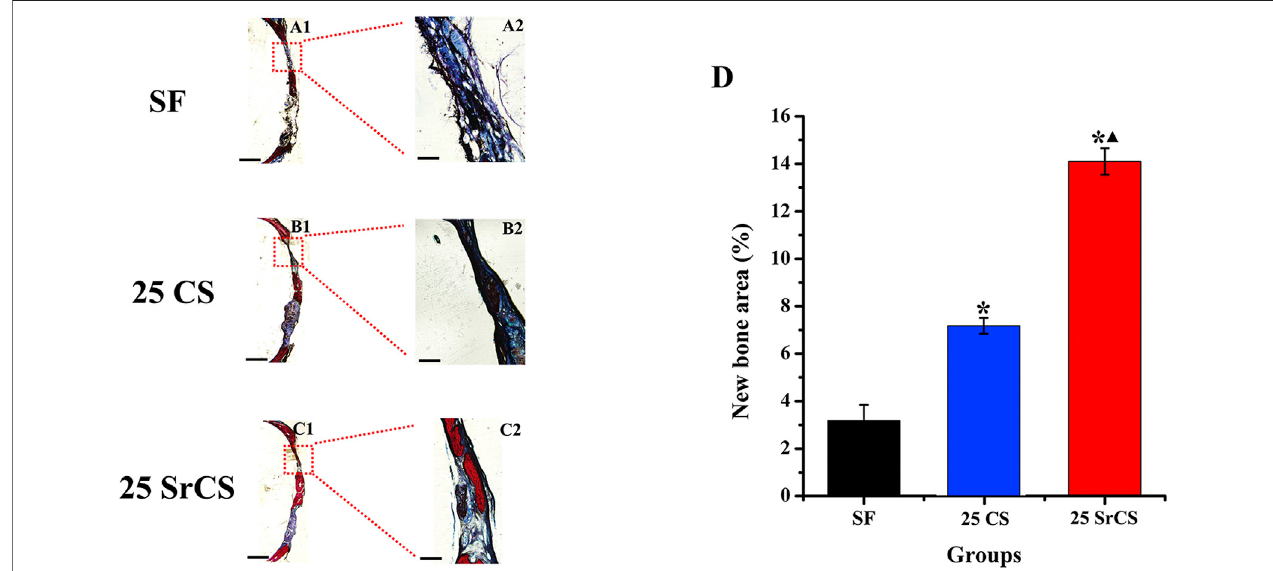
FIGURE 11 | Histological images of newly formed bone in calvarial defects. (A – C) Histological images of newly formed bone in calvarial defects. (D) Percentage of the new bone area assessed by histomorphometric analysis. * p < 0.05 indicates the other groups vs. the SF group, and ▲ p < 0.05 indicates the 25 SrCS group vs. the other groups, A1 – C1: scale bar = 1 mm; A2 – C2: scale bar = 100 μ m.